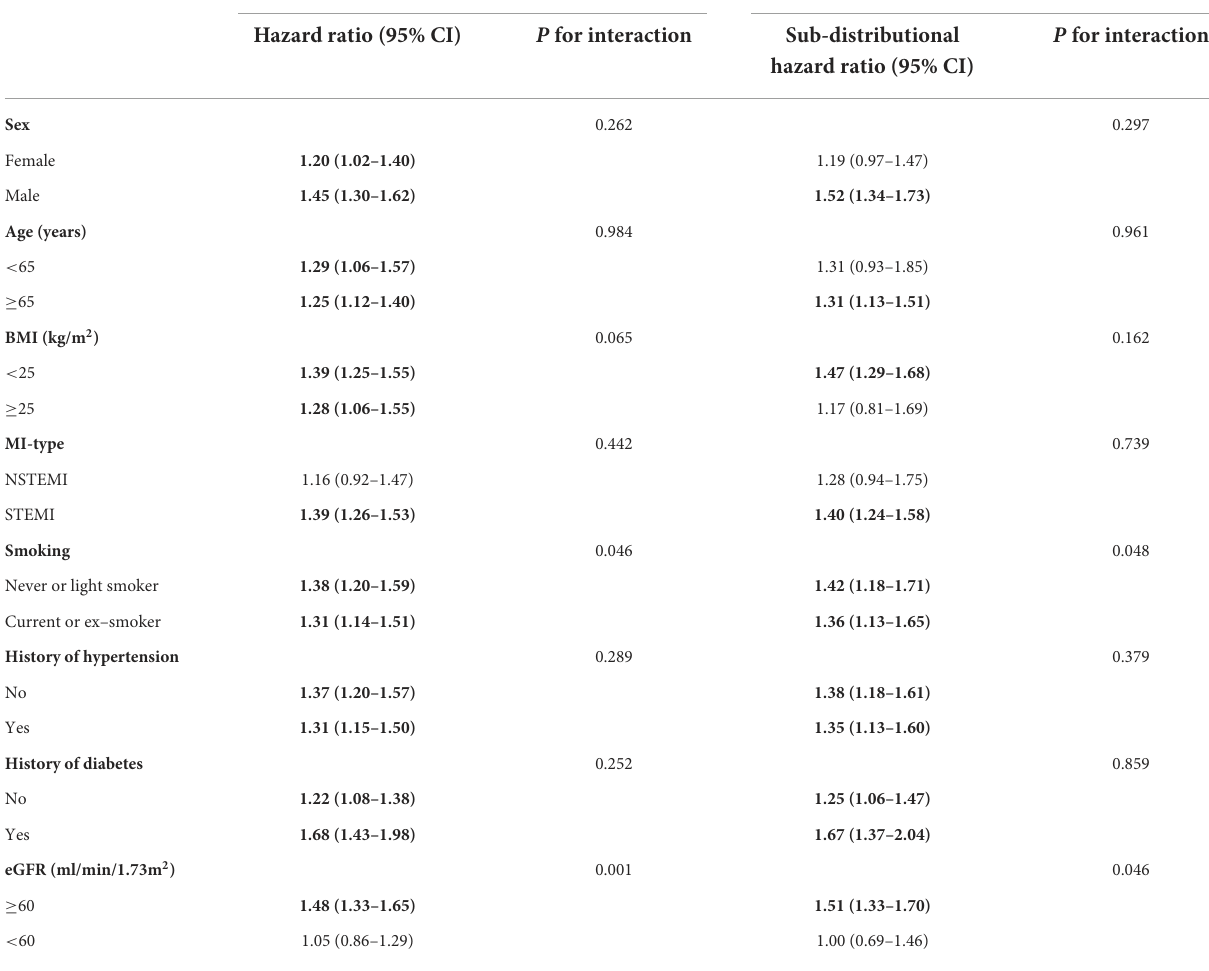
TABLE 5 Stratified analysis of all-cause death and cardiac death for serum